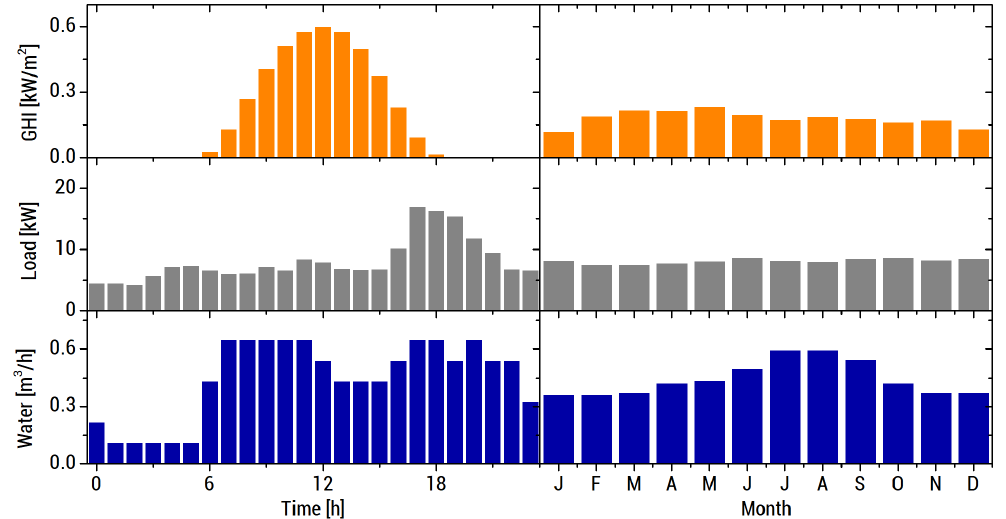
Figure A4. Daily and monthly average electric, water, and GHI profiles on Camasusu Island. Energies 2020 , 13 , x FOR PEER REVIEW